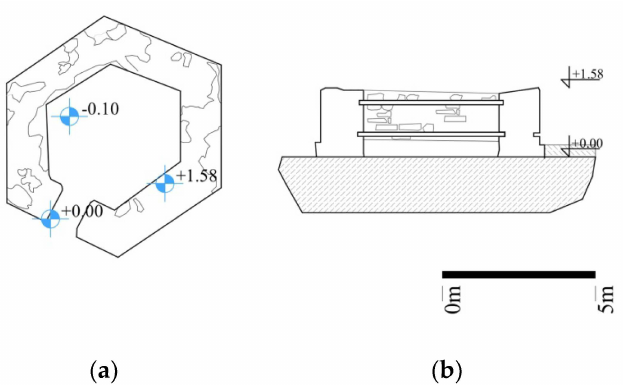
Figure 24. Drawings of the Tower Dzephana. ( a ) Base—foundation of the tower. ( b ) Cross—section of the tower (Drawigns: Lejla